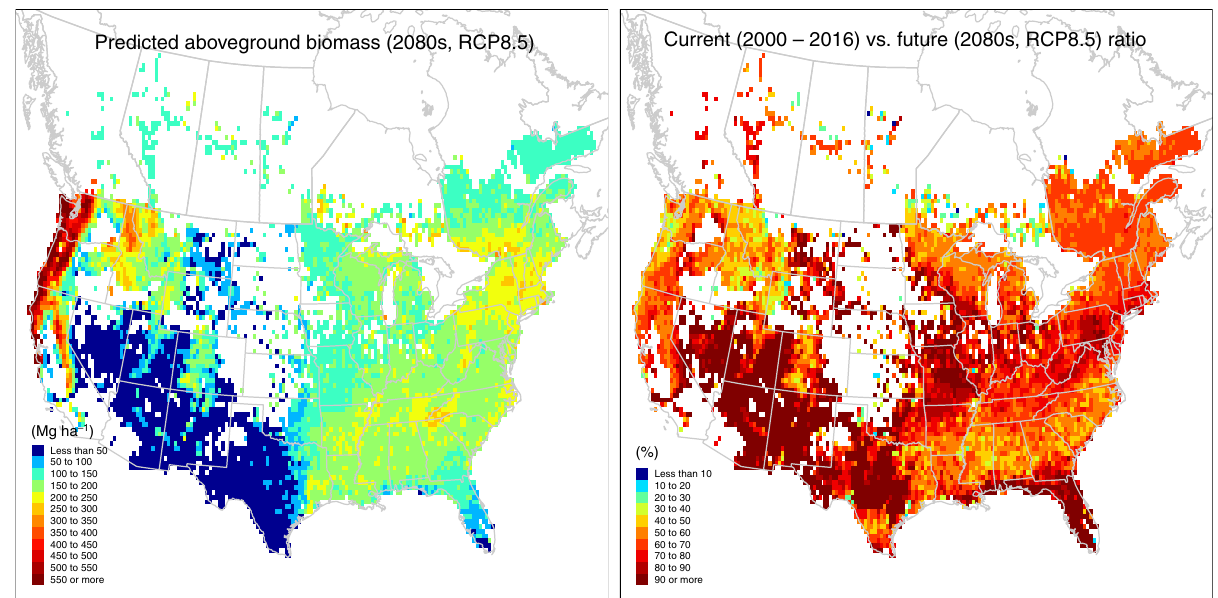
Fig. 4 Geographic distributions of future forest aboveground biomass and current vs. future ratio. The modeled aboveground biomass across North America during the future period, 2080s, under the RCP8.5 scenario, is used together with the current biomass (Fig. 2) to calculate the ratio of current vs. future biomass. The ratio summarizes the extent to which the current biomass approaches the future biomass potential under the best-case circumstances of no disturbances. Both maps are averaged at the 10-min longitude by latitude resolution from inventory plots. GIS data source: GADM database of Global Administrative Areas